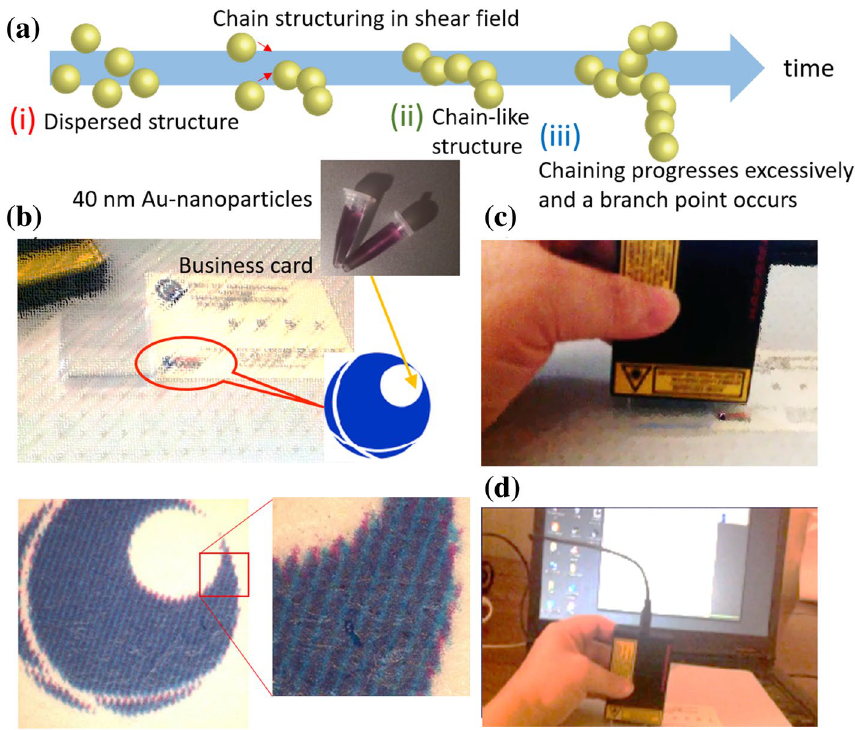
Figure 1. Experimental overview: ( a ) Schematic of the time evolution of Au nanoparticles aggregates and formation of a chain structure. With time evolution under the shear field, the following nanostructured aggregates are sequentially formed: (i) dispersed structure, (ii) chain-like structure, and (iii) aggregates structure with a branch point. ( b ) Magnified optical photograph of a business card with ink containing stealth nanobeacons, and the position of the spot. ( c ) Raman spectroscopic measurement of the spotting position and ( d ) spectrum detection result from the ink, including the stealth nanobeacons.